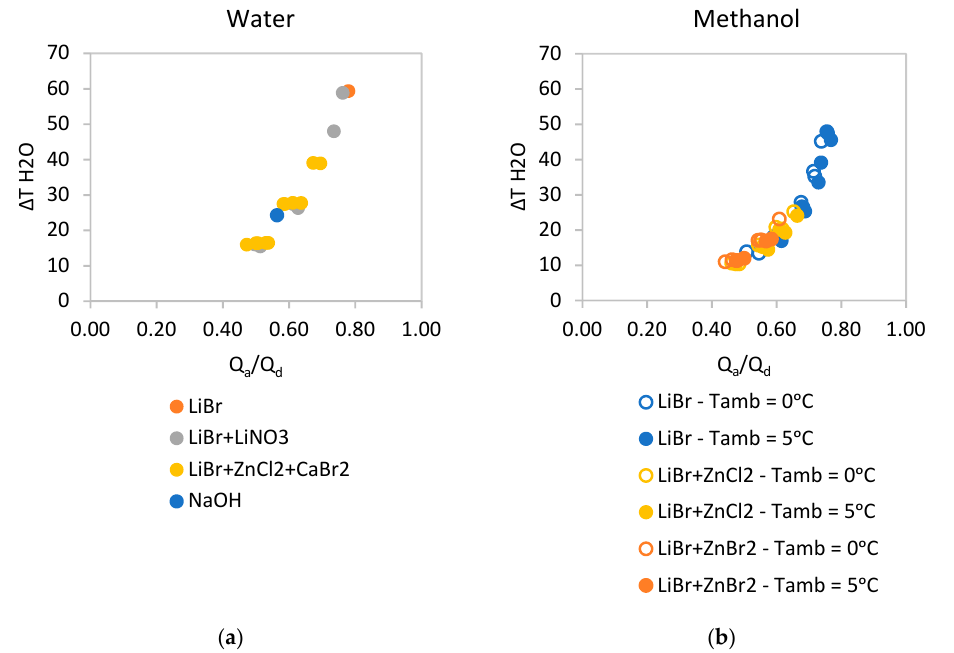
Figure 9. ( a ) Contains the performance of feasible water-based pairs at an ambient temperature of 5 °C and ( b ) Feasible methanol-based pairs. The different points correspond to a range of desorbing and absorbing temperatures ( 𝑇 (cid:3028) = 45, 50, 55 °C and 𝑇 (cid:3031) = 𝑇 (cid:3028) + 2, 4, 6, 8, 10 °C ). In the case of water, the ambient temperature is 5 °C and in the case of the methanol two ambient temperatures were simulated, 5 and 0 °C.